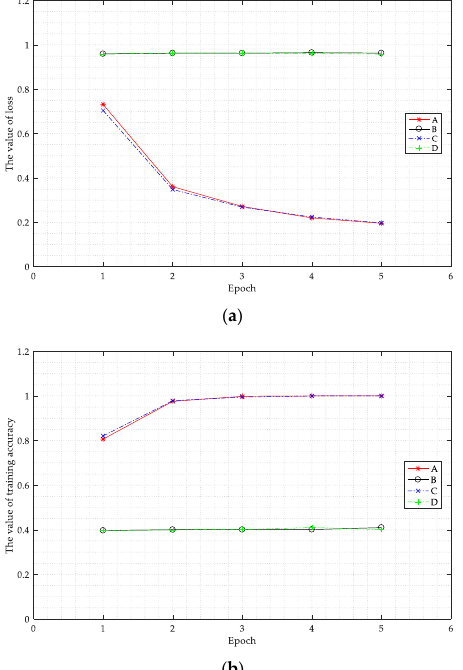
Figure 11. Value of the loss function ( a ) and the value of the training accuracy of the training set ( b ) as the epoch changed when the batch normalization layer was added into different positions. The batch normalization (BN) layer was added into the fully connected layer, the output layer, and the two convolution layers, expressed as A. The BN layer was added into the two convolution layers, expressed as B. The BN layer was added into the fully connected layer and the output layer, expressed as C. Finally, the BN layer was not added, expressed as D.